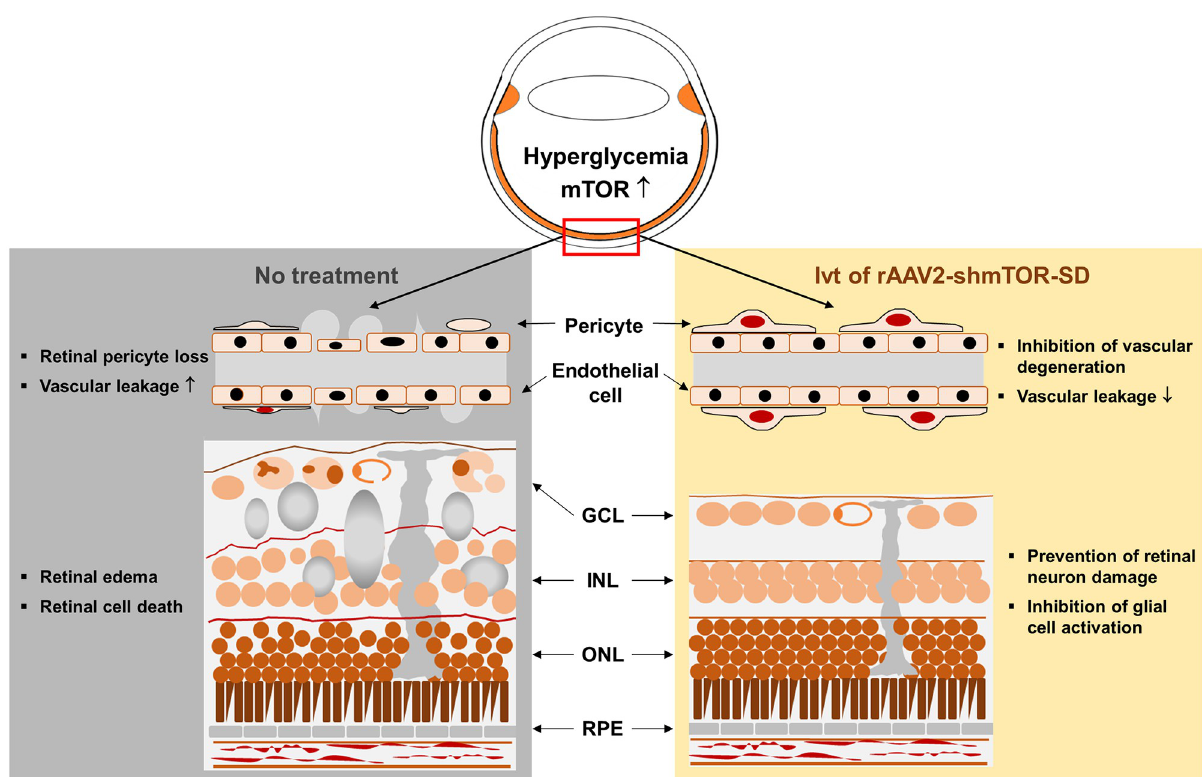
Fig 7. Therapeutic efficacy of a novel mTOR-inhibiting shRNA for the treatment of diabetic retinopathy. Early DR processes include pericyte loss and vascular leakage, which may lead to the development of edema, cell death, and disruptions in the retinal cell layers if left untreated. Intravitreal administration of rAAV2-shmTOR-SD was shown to effectively address these aspects of DR in a STZ-induced diabetic mouse model, further demonstrating its potential as a human gene therapeutic.